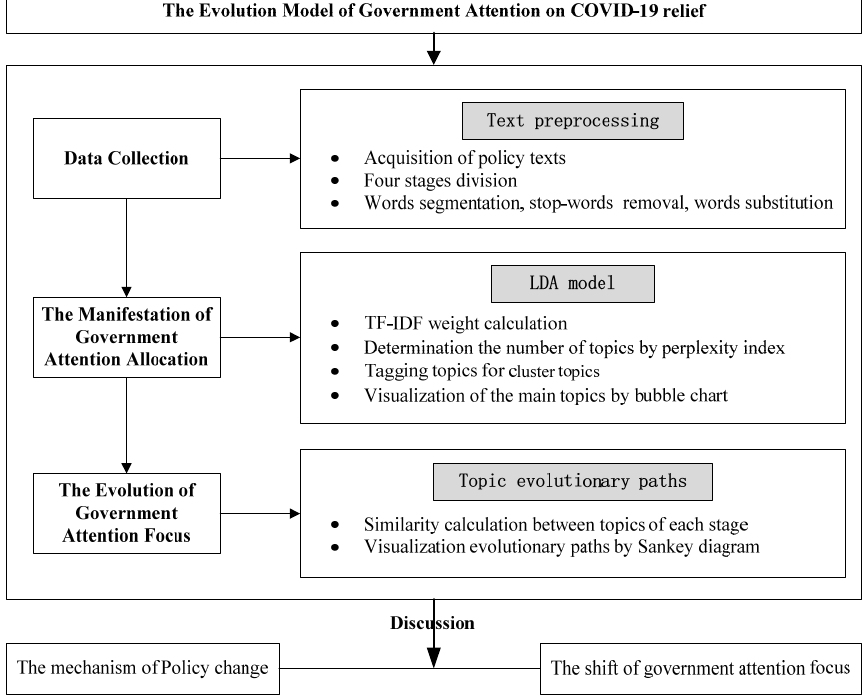
Figure 1. Evolution model of government attention on COVID-19 relief.